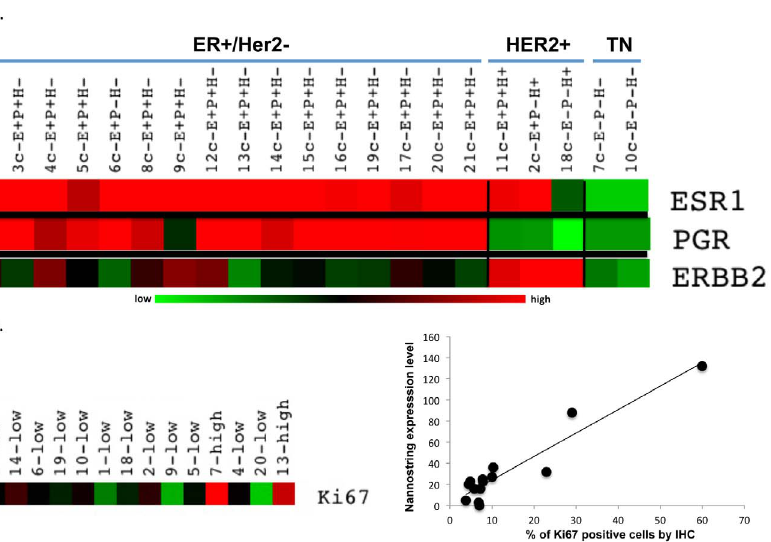
Figure 1. Correlation between CNBs clinical data and Nanostring nCounter expression values. Color coding- green represents low nanostring expression level and red represents high nanostring expression level. Expression levels are log transformed. A. ER + /HER2 negative breast cancers had high ER expression and low HER2 Nanostring expression, HER2 positive tumors displayed high ERBB2 expression levels and triple negative (TN) cancers had low ER and HER2 expression levels. E=ER, P=PR, H=Her2. B. Ki67 high defined as an IHC score of above 14% and low as # 14%. Scatter plot showing correlation between the Nanostring Ki67 expression level (Y axis) and IHC Ki67 score (x-axis). doi:10.1371/journal.pone.0064225.g001 PLOS ONE |